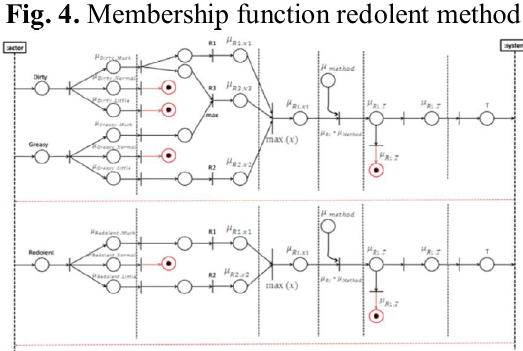
Fig. 4. Membership function redolent method